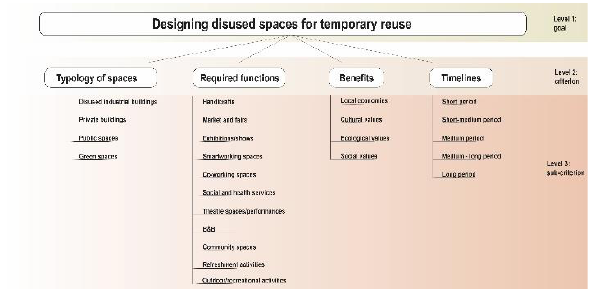
Figure 4 . Hierarchical structure of the applied multi-criteria